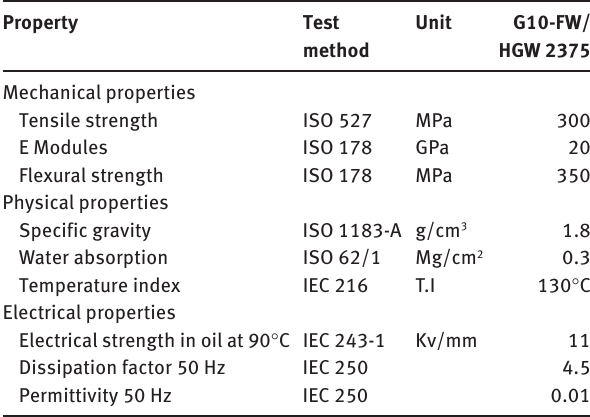
Table 1 Typical properties of filament-wound tubes.